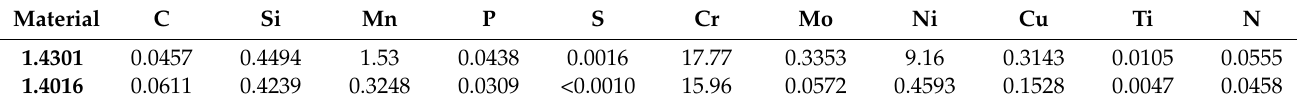
Table 1. Chemical composition of the 1.4301–X5CrNi18-10 and the 1.4016–X6Cr17 in